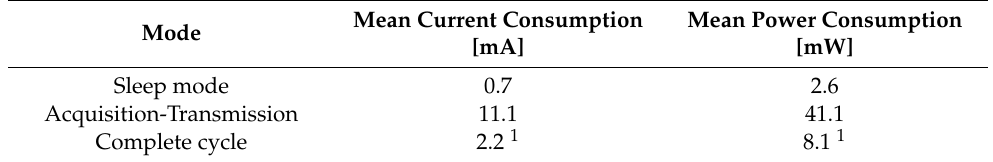
Figure 7. Consumption test: ( a ) Scheme representing the test set-up and ( b ) current consumption results [1] © 2020 IEEE. Table 5. Consumption data